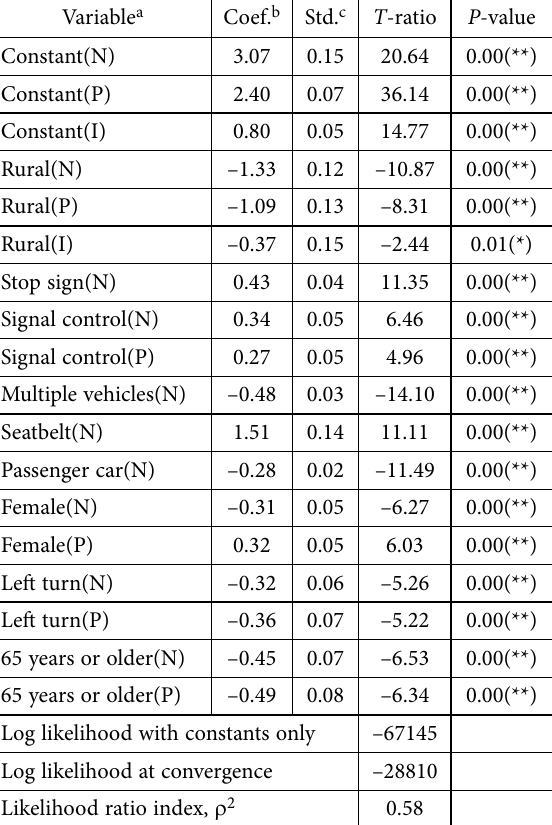
Table 4. Driver’s injury severity model estimation for non-